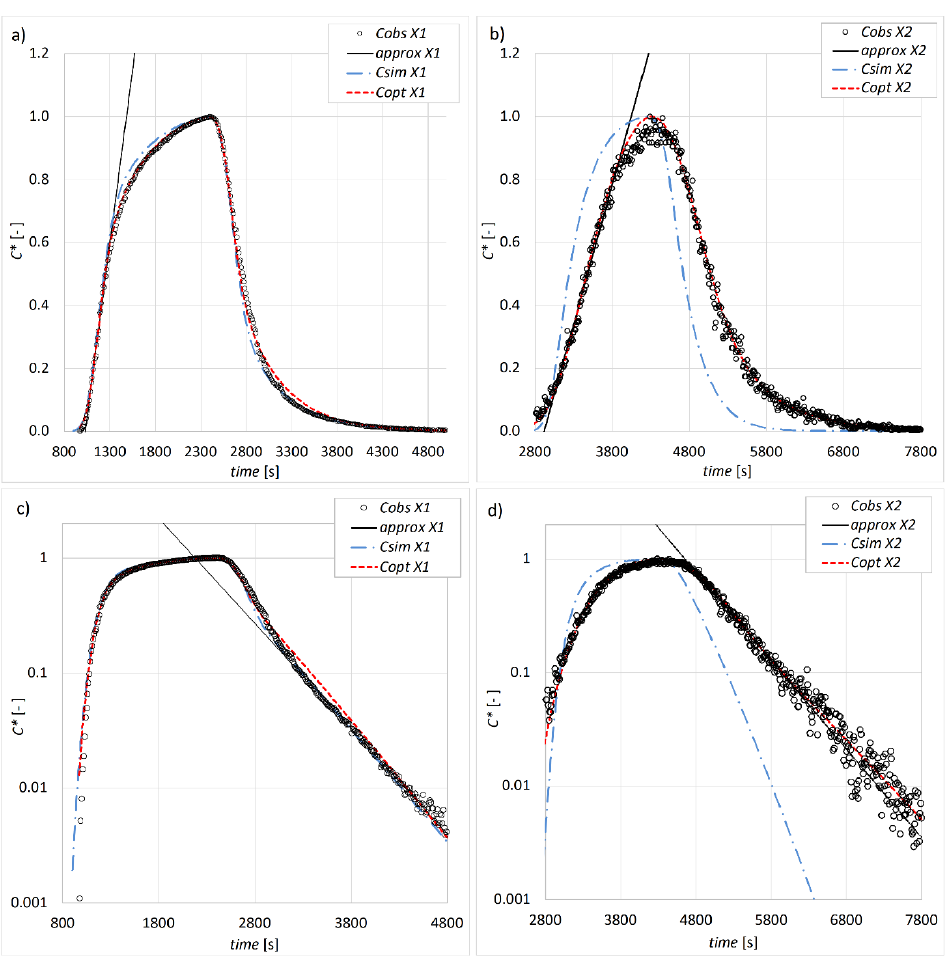
Figure 3. Normalized observed concentration data (“Cobs”, circles), the approximating trendlines (solid black lines), the simulated BTCs from the approximations (“Csim”, dashed-dot blue lines) and the optimized simulated BTCs (“Copt”, dashed red lines), for section X1 (panels ( a ) and ( c ) and section X2 (panels ( b ) and ( d )). Panel ( a ) and ( b ) refer to the approximation of the rising limb of the BTC. Panel ( c ) and ( d ) are in semi-log scale and refer to the approximation of the decreasing part of the BTC.